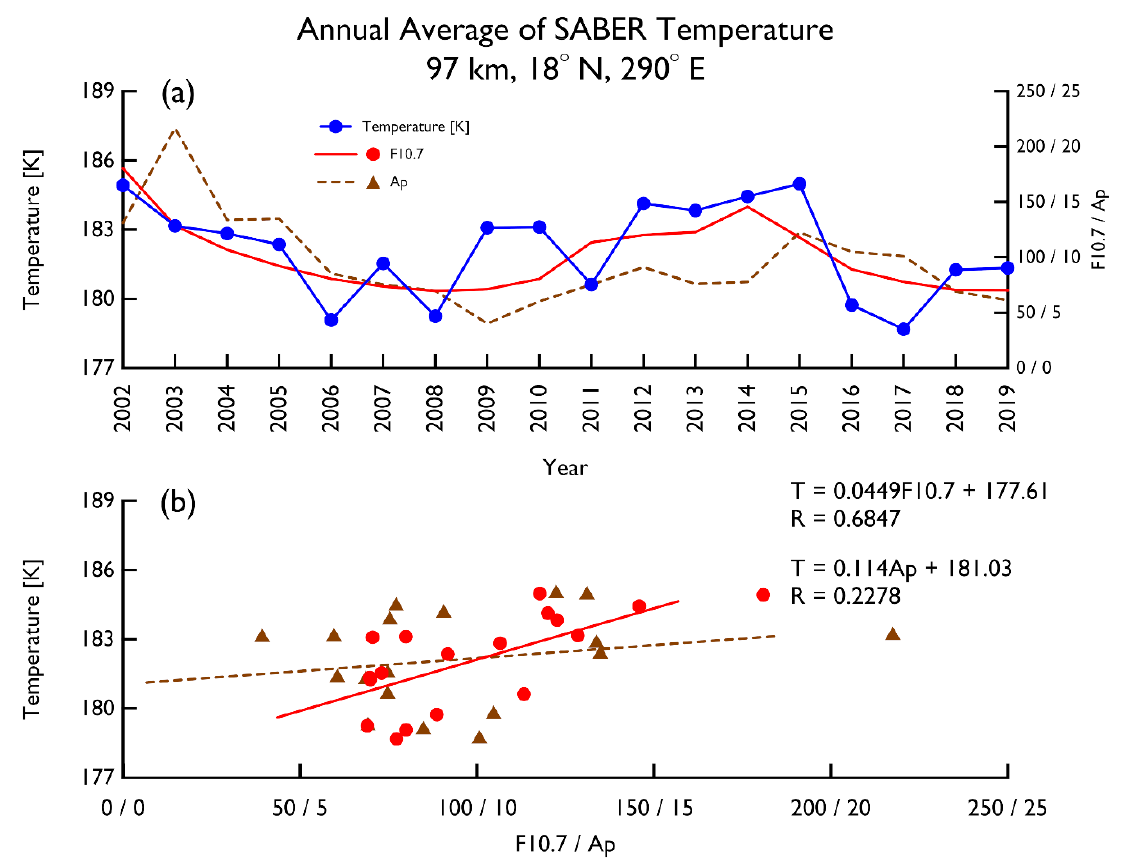
Figure 3. Annual average of SABER temperature at 18° N, 290° E at 97 km. ( a ) Time series of temperature (blue line with dots), F10.7 (red line), and Ap index (brown dashed line). ( b ) Trend analysis of temperature as a function of the F10.7 (red line and dots) and of the Ap index (brown dashed line and triangles).